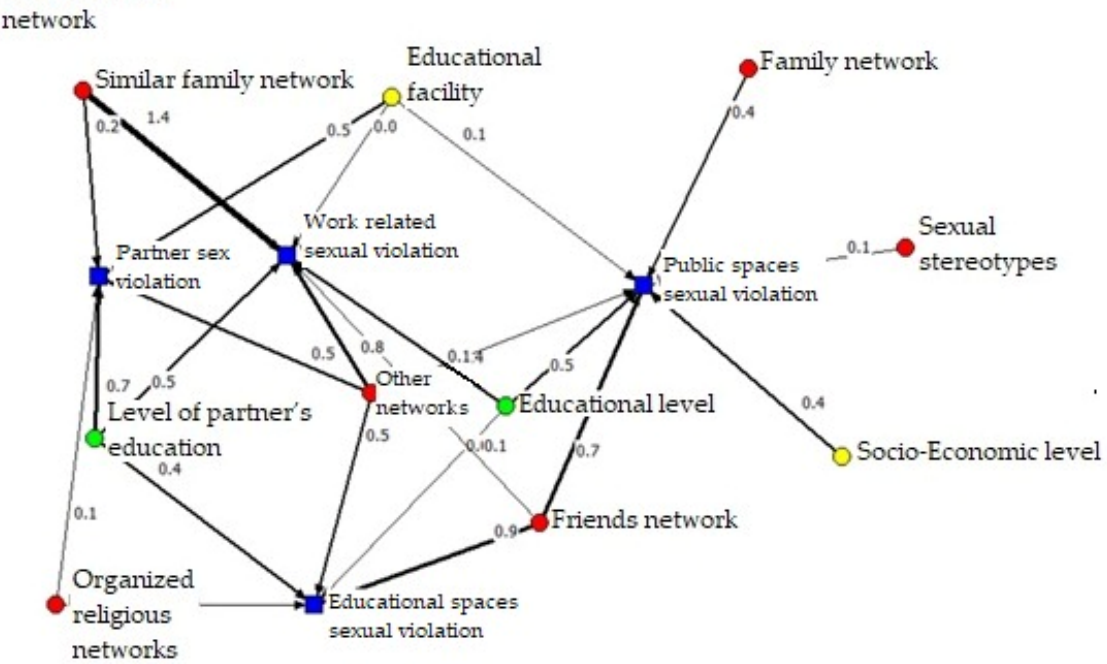
Figure 4. Risk network between capital and sexual violence. Table 6. Risk network indicators of degree centrality and proximity of the nodes.